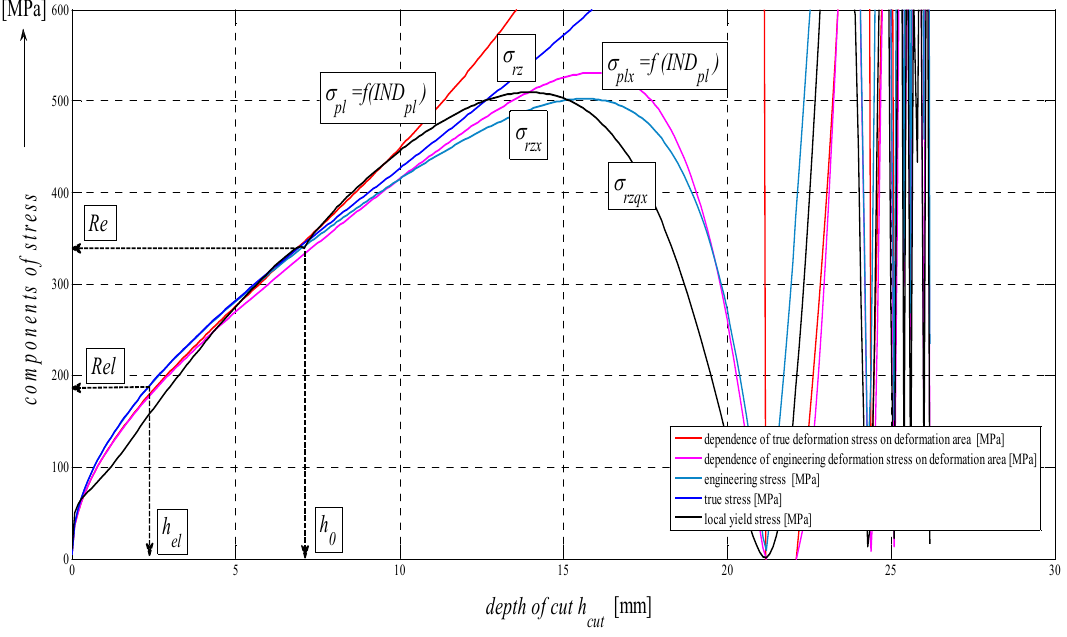
Figure 8. Analysis of components of stress on depth of cut for AISI 304 material, E mat = 195 GPa.